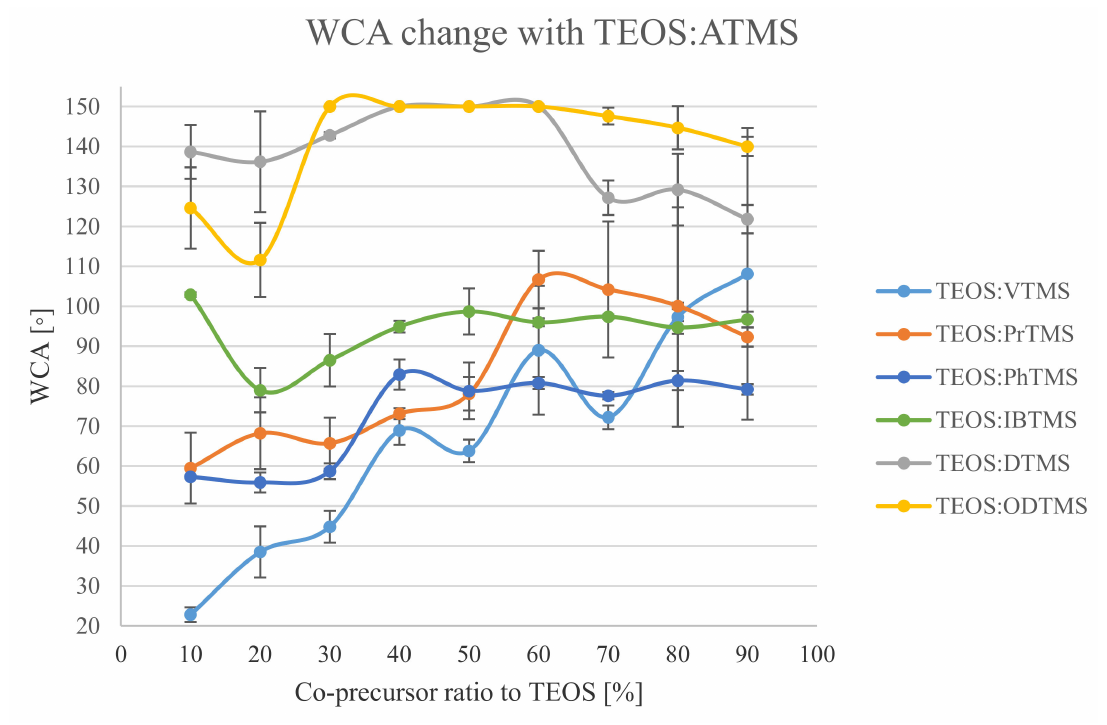
Figure 4. WCA change with co-precursor type and